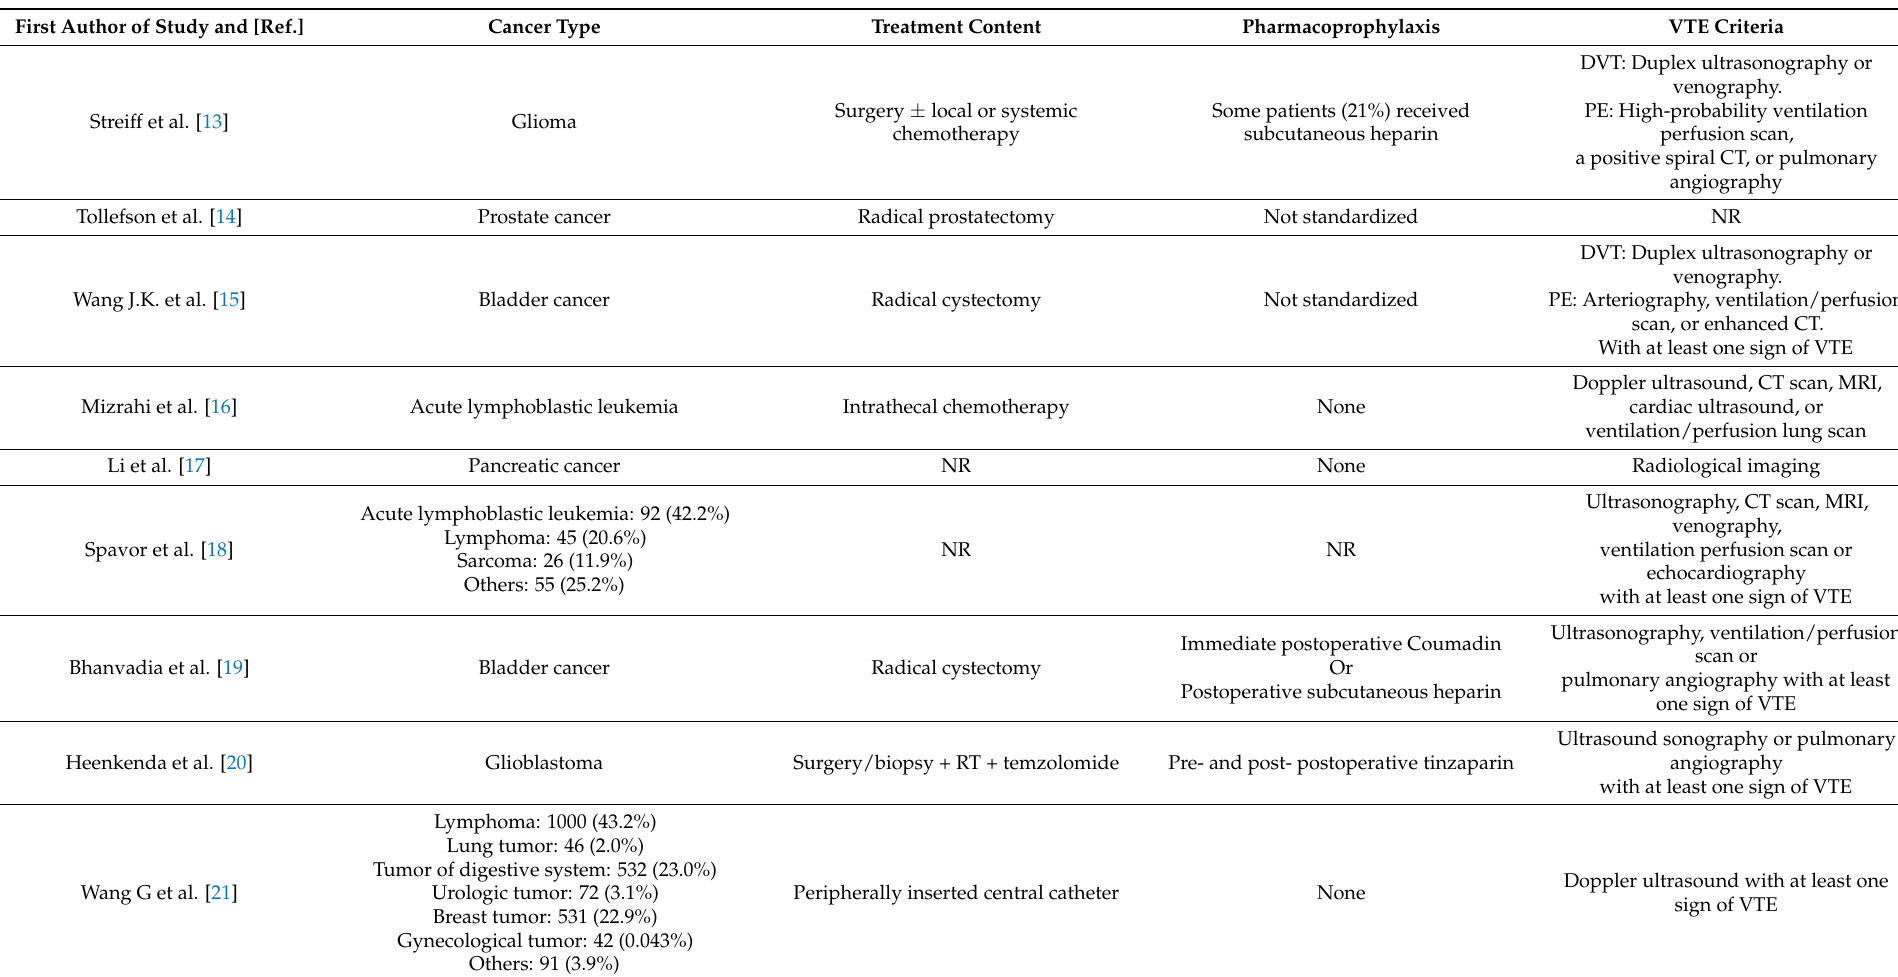
Table 3. Clinical characteristics of study